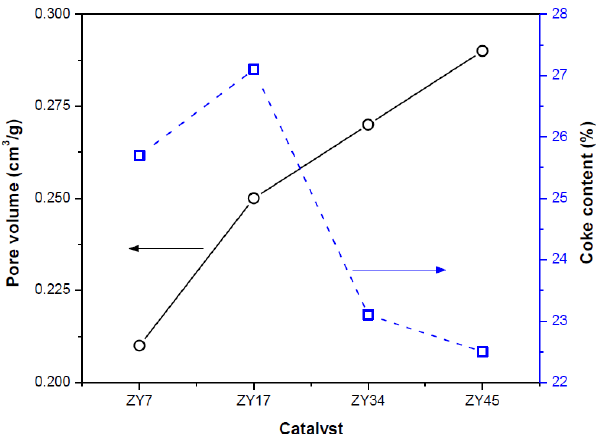
Figure 14. Comparison of the pore volume of the fresh zeolites and the coke content of spent cata- lysts.